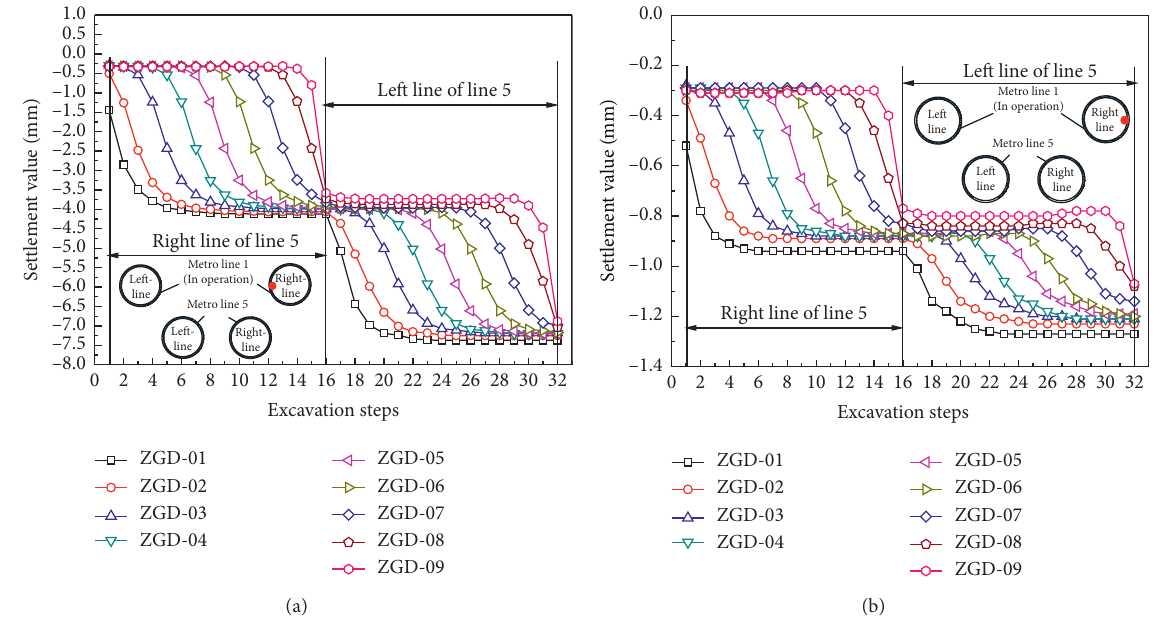
Figure 6: Settlement of right-line arch waist of line 1 caused by the construction of line 5. (a) Left-side arch waist. (b) Right-side arch waist.